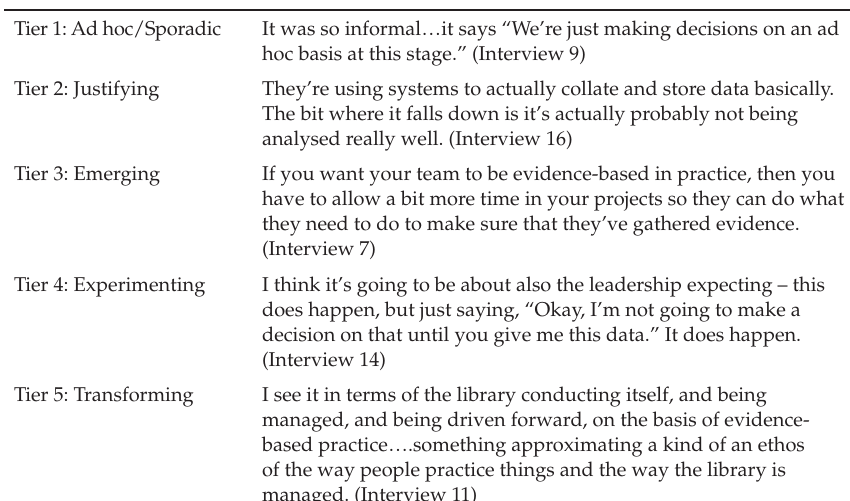
Table 2: Interviewees’ experience of the Engagement dimension, Evidence Based Library and Information Practice Capability Maturity